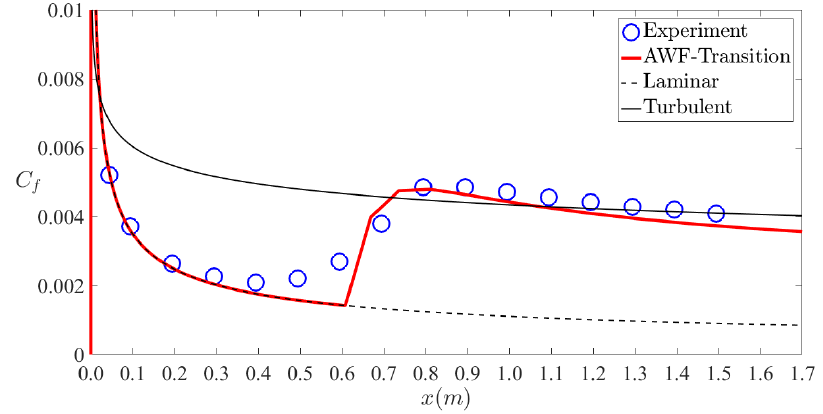
Figure 4. Skin friction coefficient distribution along a flat plate of T3A.